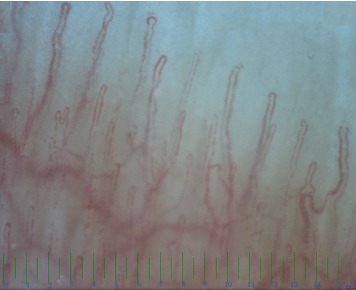
Normal morphology, structure, diameter and density are seen in nail fold capillaroscopy in a normal 8 years old girl.